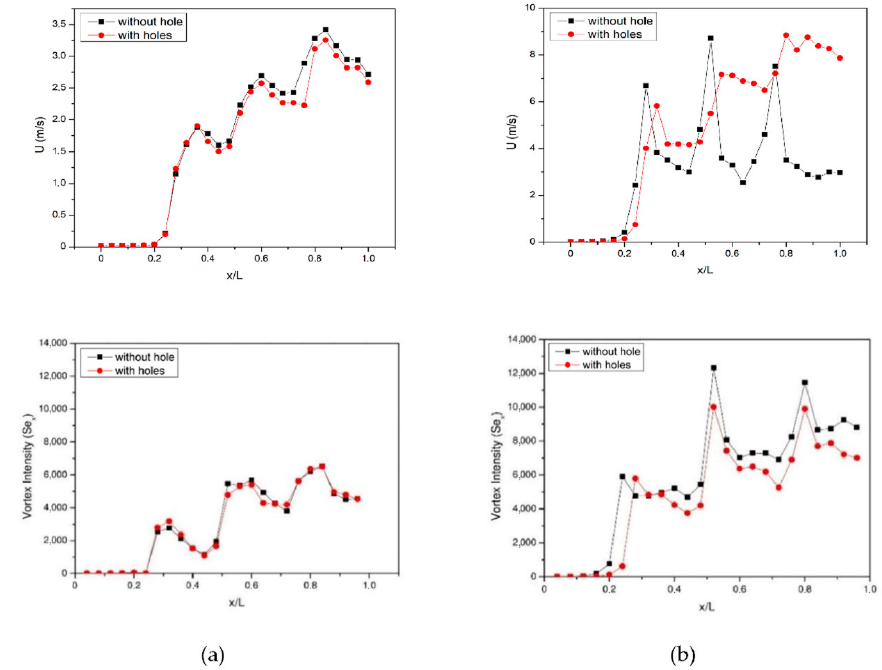
Figure 8. Tangential velocity and local vortex intensity for ( a ) RW VG and ( b ) CRW VG at the flow velocity of 2 m/s.